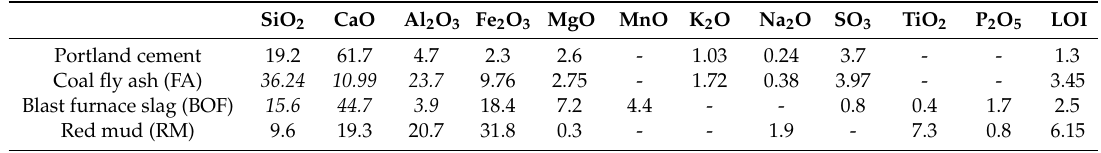
Table 1. Chemical composition (wt.%) and loss on ignition (wt.%) of the